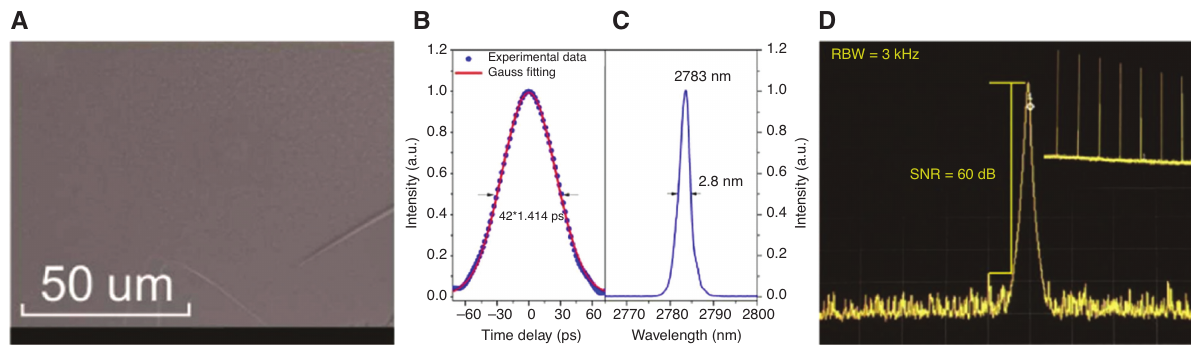
Figure 14: Mode-locked fiber lasers with various SAs at the 2.8- μ m region based on BP. (A) SEM of BP. (B) Autocorrelation traces. (C) Optical spectrum. (D) RF spectrum and wide-range RF spectrum (inset). Reproduced with permission from Ref. [375]. Copyright 2016, Optical Society of America.